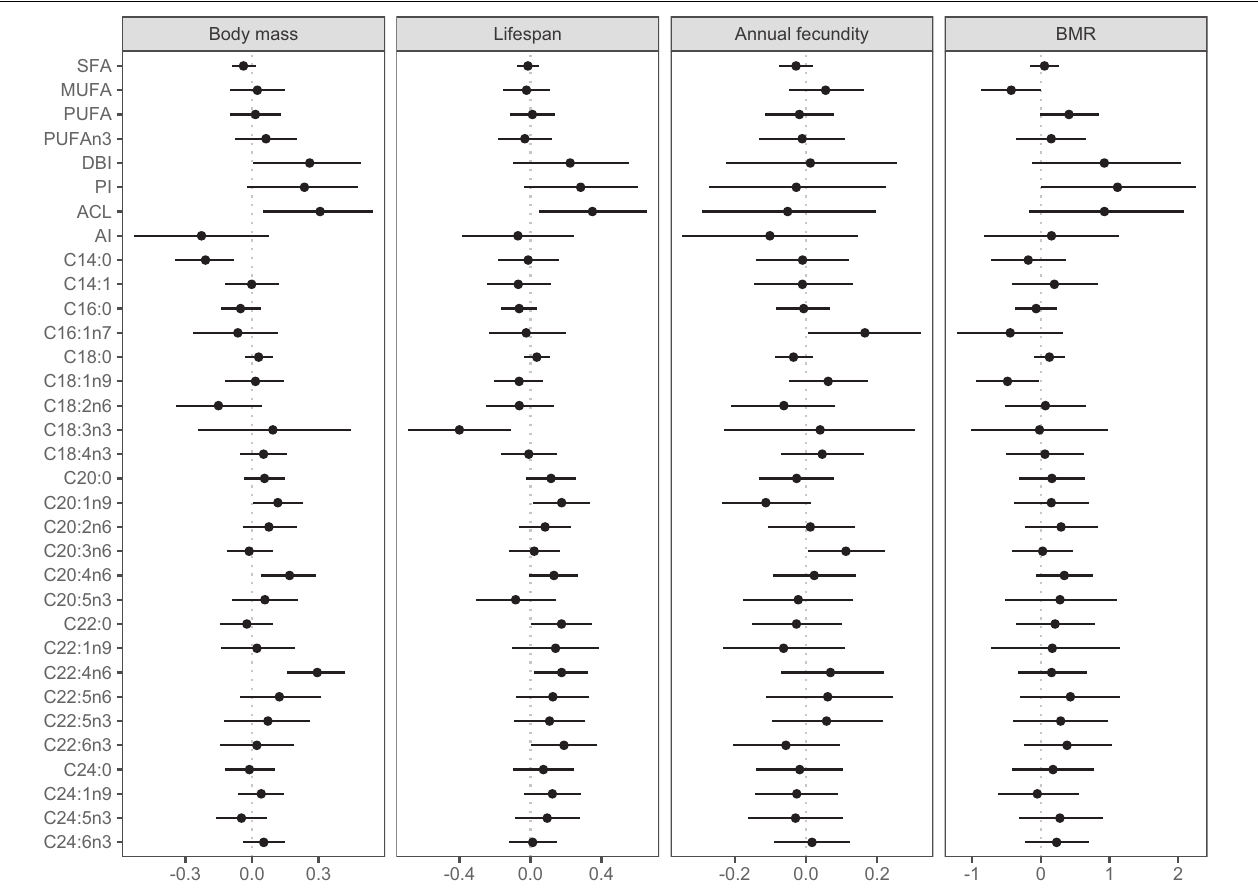
FIGURE 3 | Effects of body mass, life span, annual fecundity, and BMR on liver FA composition. Shown are average marginal effects from Bayesian phylogenetic models and their 95% credible intervals. The 95% credible interval represents a range of values that, given the observed data, contain the true effect value with 95% probability. We consider the effect to be significantly supported if the 95% credible interval do not contain zero. Effect of body mass is from a model with body mass as a sole fixed-effect predictor. The effect of life span was controlled for body mass, number of recoveries, and migration distance. The effect of annual fecundity was controlled for body mass and migration distance. The effect of BMR was controlled for body mass. Body mass, life span, number of recoveries, annual fecundity, BMR, and anti-inflammatory index were log-transformed. All the non-proportional response and predictor variables were standardised by z -transformation. Beta regression and Gaussian regression were used for proportional and non-proportional data, respectively. SFA – saturated fatty acids, MUFA – monounsaturated fatty acids, PUFA – polyunsaturated fatty acids, DBI – double bond index, PI – peroxidizability index, ACL – average chain length, AI – anti-inflammatory